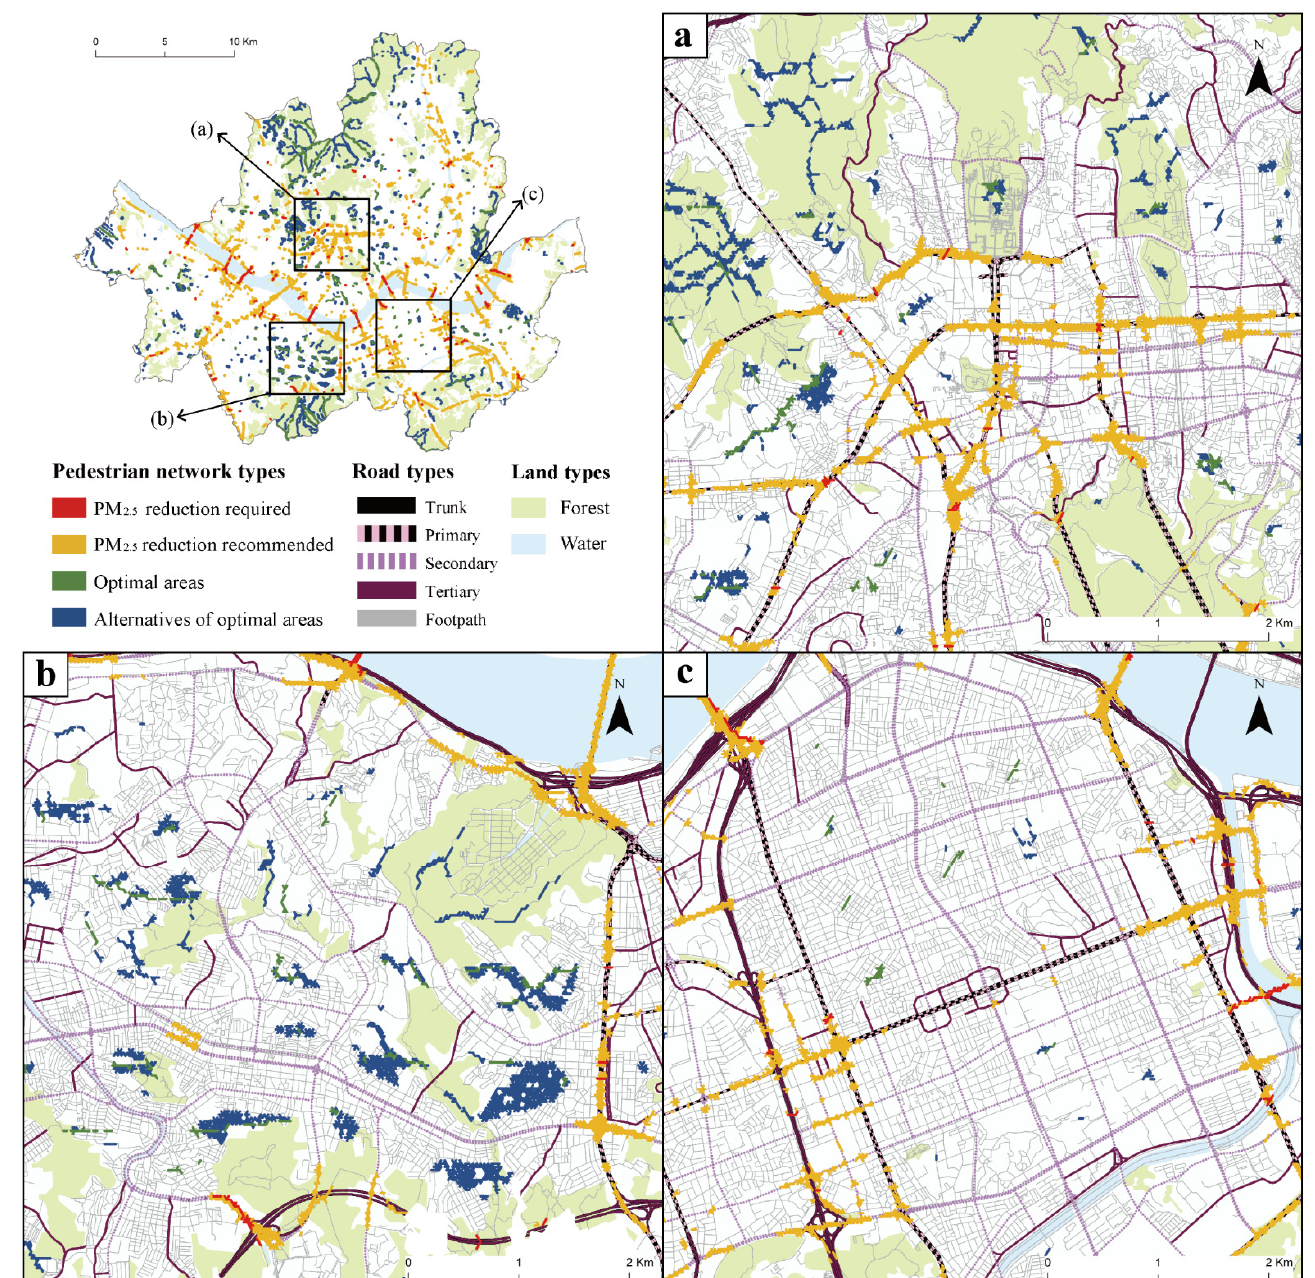
Figure 6. Map showing the pedestrian network pattern examples, ( a ) PM 2.5 reduction recommended, ( b ) alternatives of optimal areas, and ( c ) low centrality centered areas.